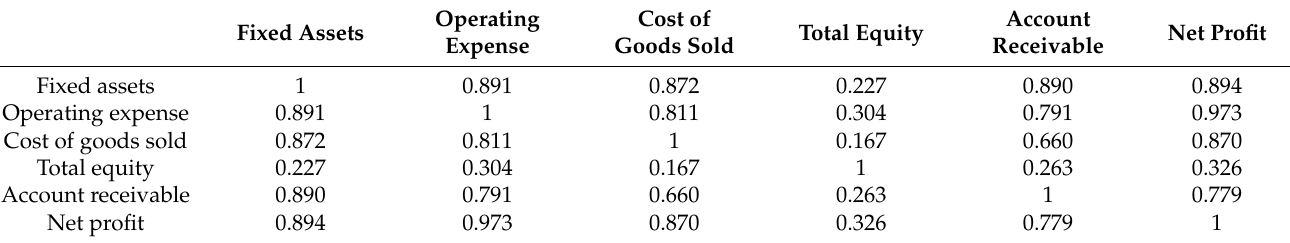
Table 6. Correlation of input and output data in 2018.